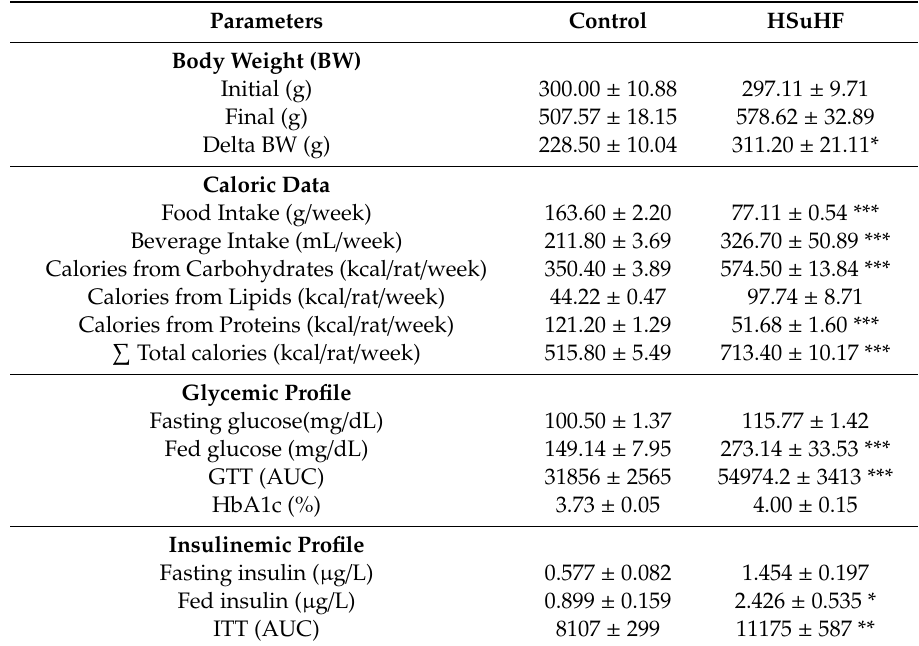
Table 3. Body weight, caloric intake and glycemic and insulinemic profile.